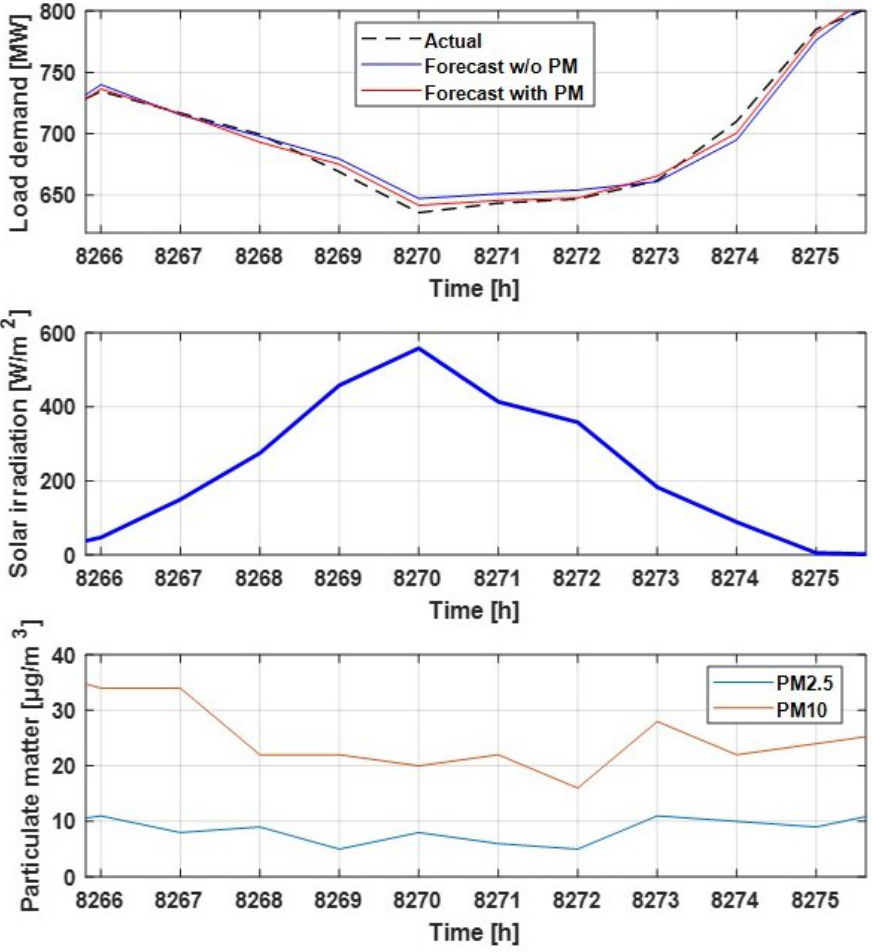
Figure 10. Comparison between the results of the load demand forecast with and without (w/o) considering particulate